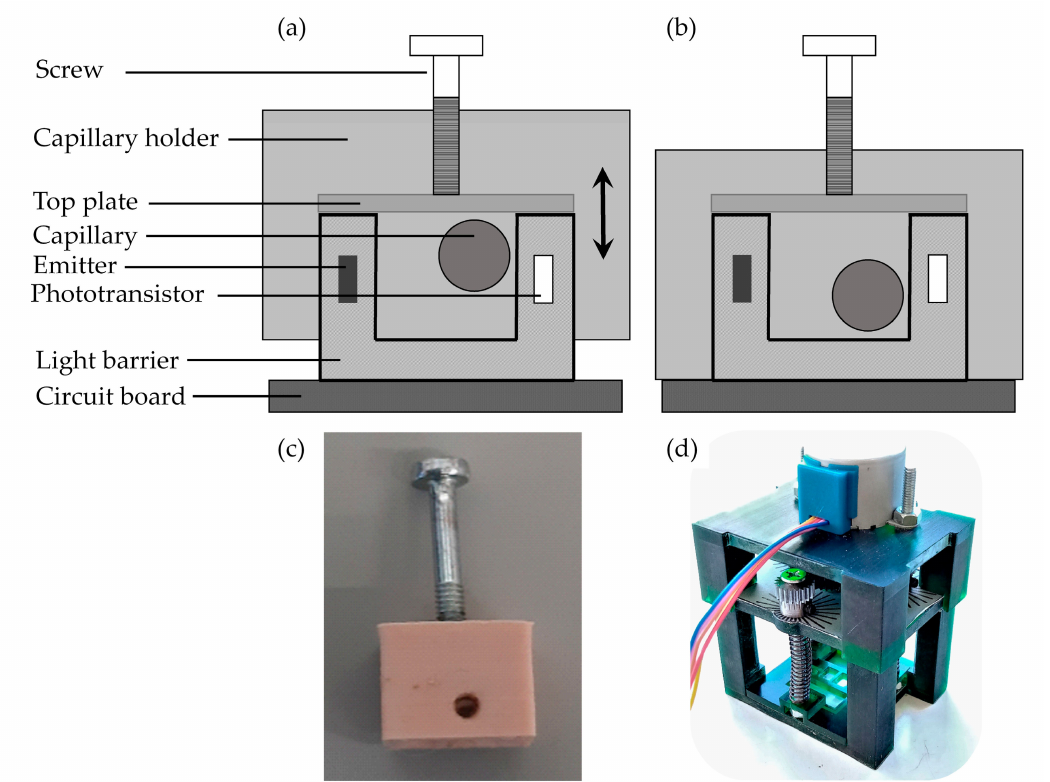
Figure 4. Schematic drawing and photos of the capillary holder. By pressing the screw against the stationarytopplate, theholder(includingcapillary)canbeloweredandraisedrelativetothetransmissive sensor. ( a ) Capillary in highest position; ( b ) capillary in lowest position; ( c ) three-dimensional (3D) printed capillary holder; ( d ) capillary holder combined with step